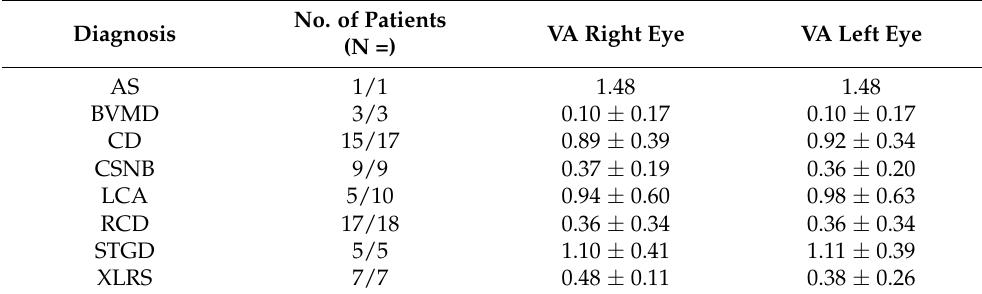
Table 2. Mean visual acuity (VA) in LogMAR by clinical diagnosis (in alphabetical order). Patients not accounted for in this table were unable to provide formal VA assessment, predominantly LCA patients who were too young for formal VA